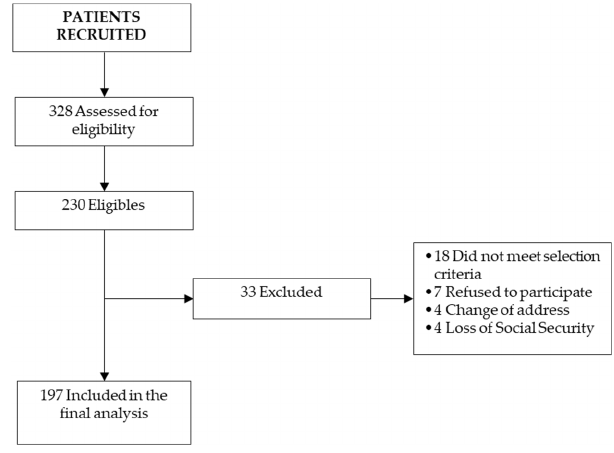
Figure 1. Study flow chart. Table 1. Patient ´ s demographic, clinical and biochemical